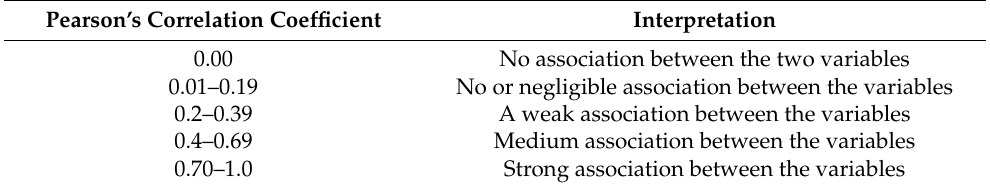
Table 4. Pearson’s correlation coefficient for the interpretation of the ETA coefficient.